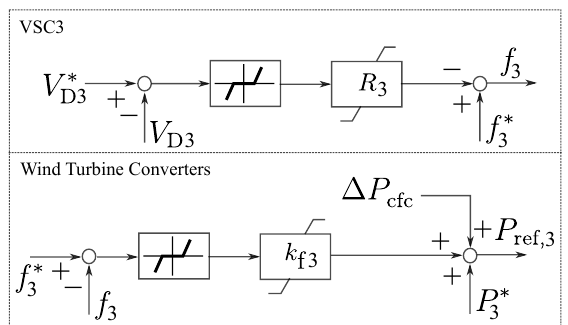
Figure 2. Voltage and frequency droop control used for VSC3 and wind turbine